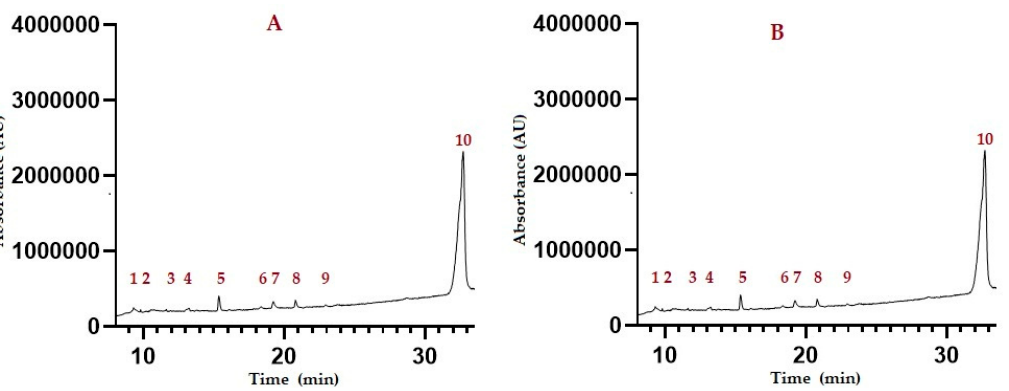
Figure 1. Chromatogram of pitahaya samples. ( A ) Chromatogram of pitahaya Selenicerus undatus . ( B ) Chromatogram of pitahaya Hylocereus polyrhizus . Table 2. Retention times and areas measured by the team, FAMEs in two varieties of pitahaya Sele- nicerus undatus and Hylocereus polyrhizus . T R (retention time). In the spaces where a hyphen was placed is an unidentified element.